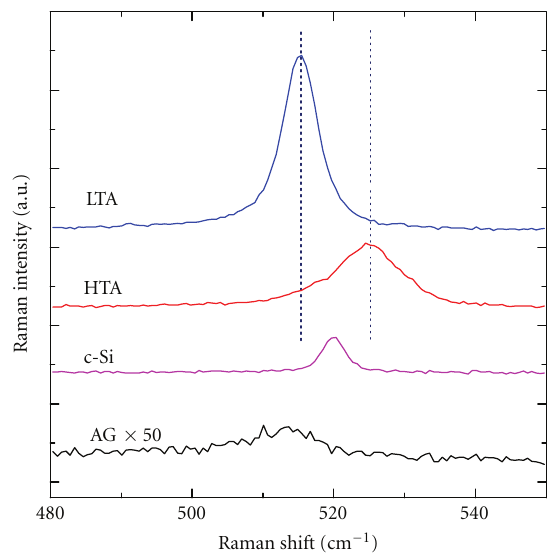
Figure 11: (From bottom to top) Raman spectra of an as-grown Si/SiO 2 superlattice free-standing film (AG), crystalline Si (c-Si), free-standing film after high-temperature laser annealing (HTA), and subsequent low-temperature laser annealing